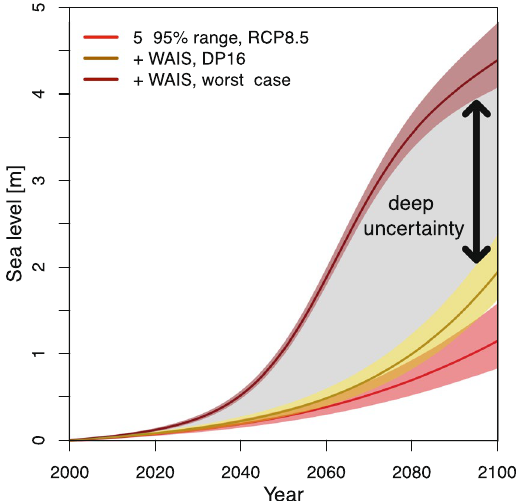
Figure 4. Future sea-level projections including deeply uncertain contribution of the